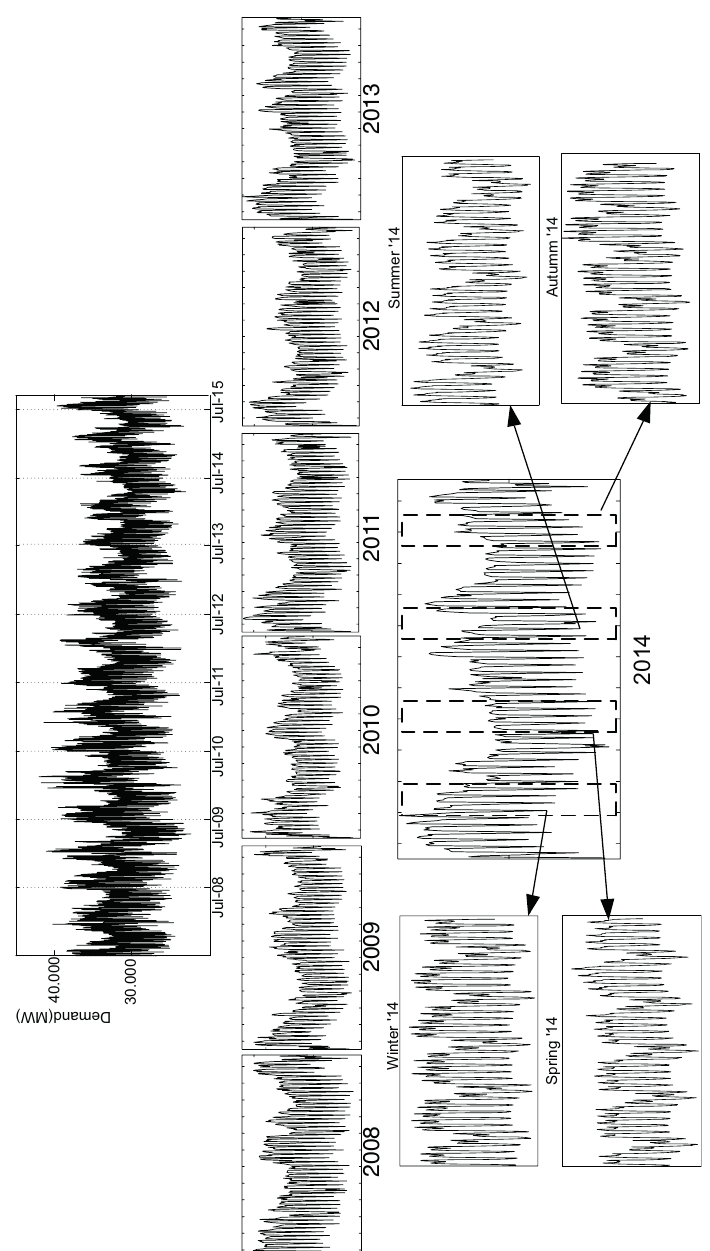
Figure 1. Demand split in years and seasons for stability